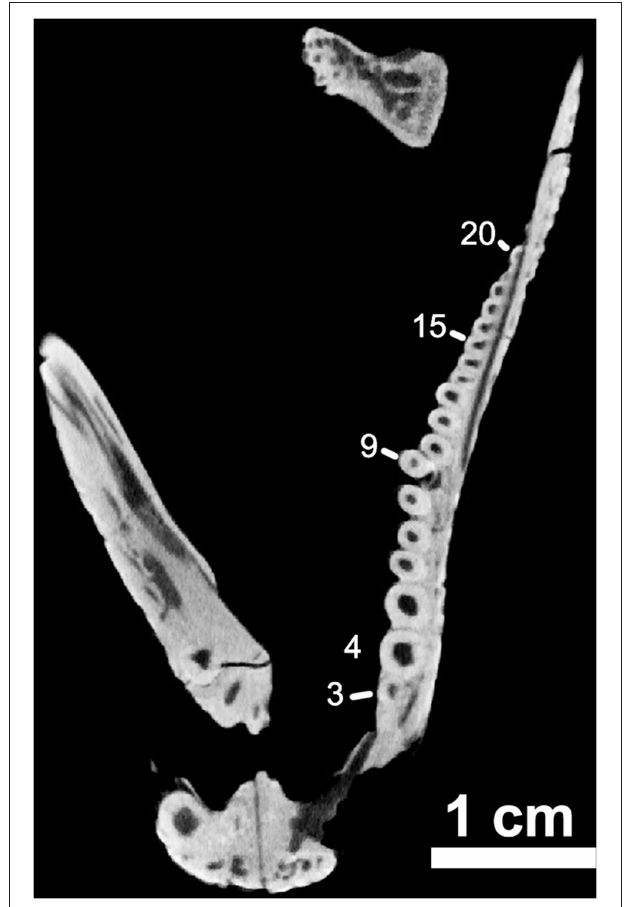
FIGURE 8 | OMNH73281a – orthographic slice of the maxillary dentition in palatal view. Note the distinctive “step” at the ninth tooth position on the left maxilla (Note – 7th visible tooth of section).